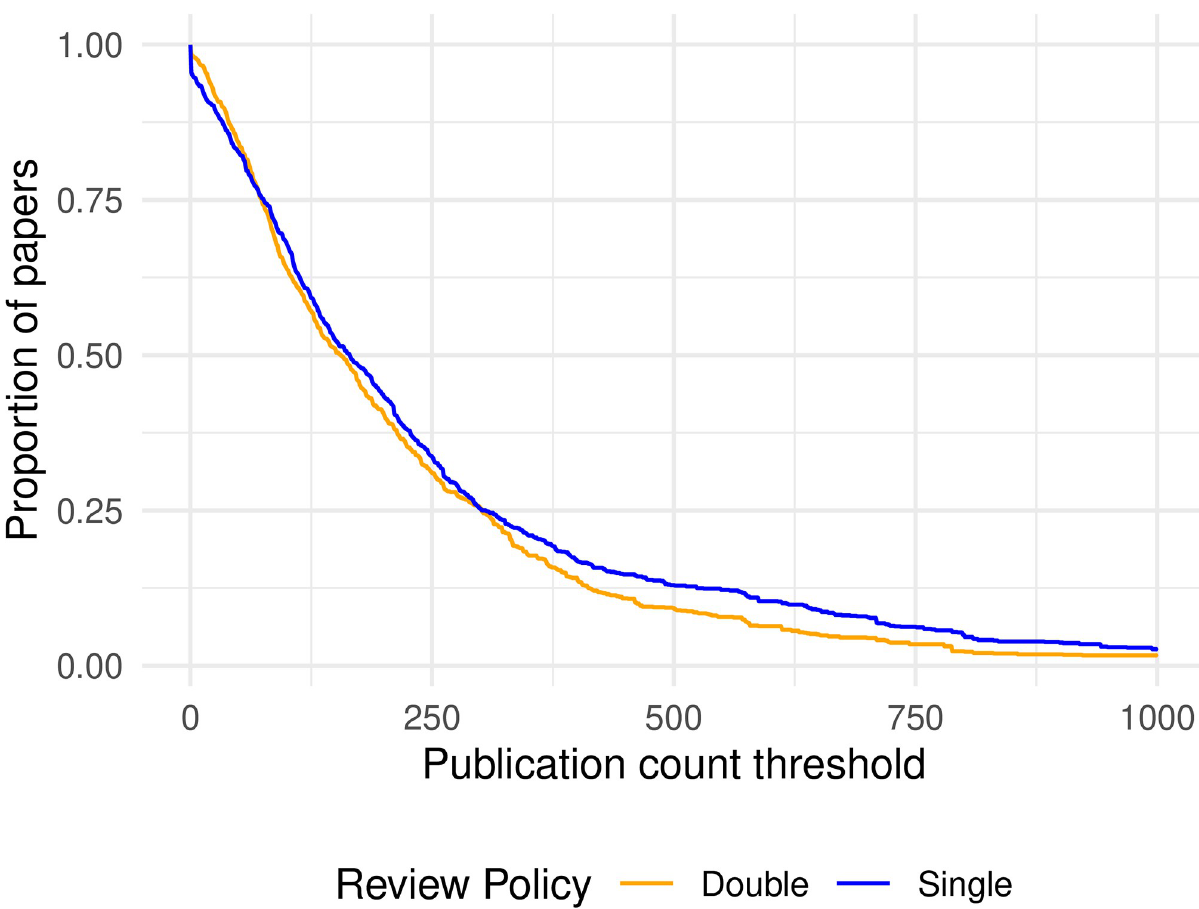
Fig 5. Proportion of papers that have at least one author with at least as many publications as the threshold (Google Scholar